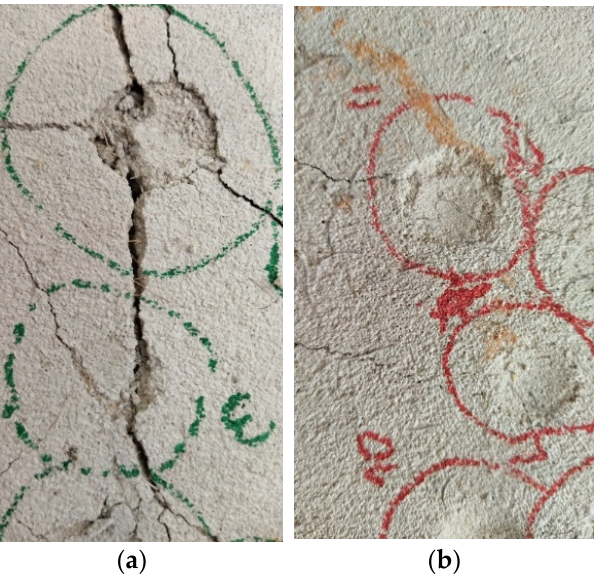
Figure 10. Fibres’ cross section ( a ) coir fibre cement-lime mortar and ( b ) textile-acrylic fibre cement- lime mortar. lime